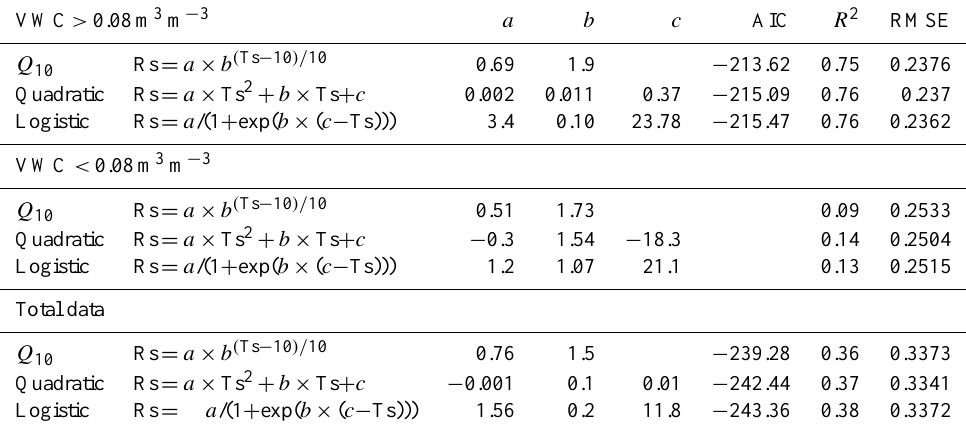
Table 2. Regression parameters ( a , b , c) from temperature-only models of soil respiration, based on the analysis of daily means. Rs (µmol